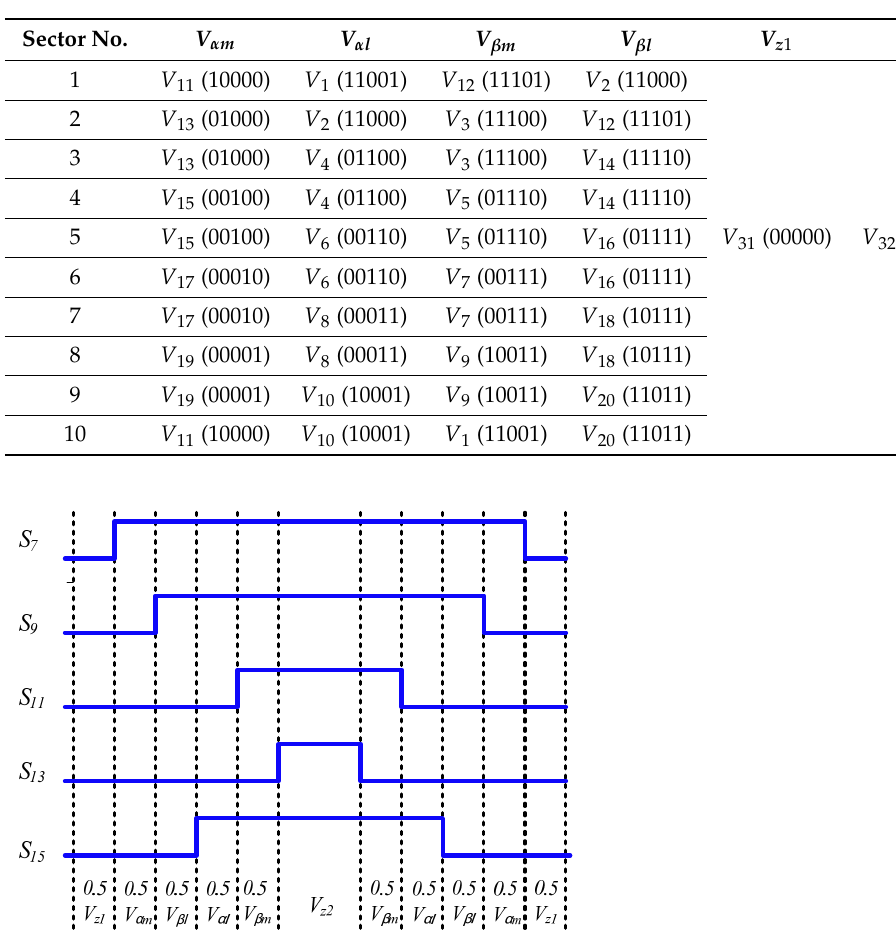
Figure 3. Switching sequence for a five-phase voltage-source inverter (VSI) in the first sector. Table 2. Inverter’s switching vectors, which minimize switching losses in all sectors.